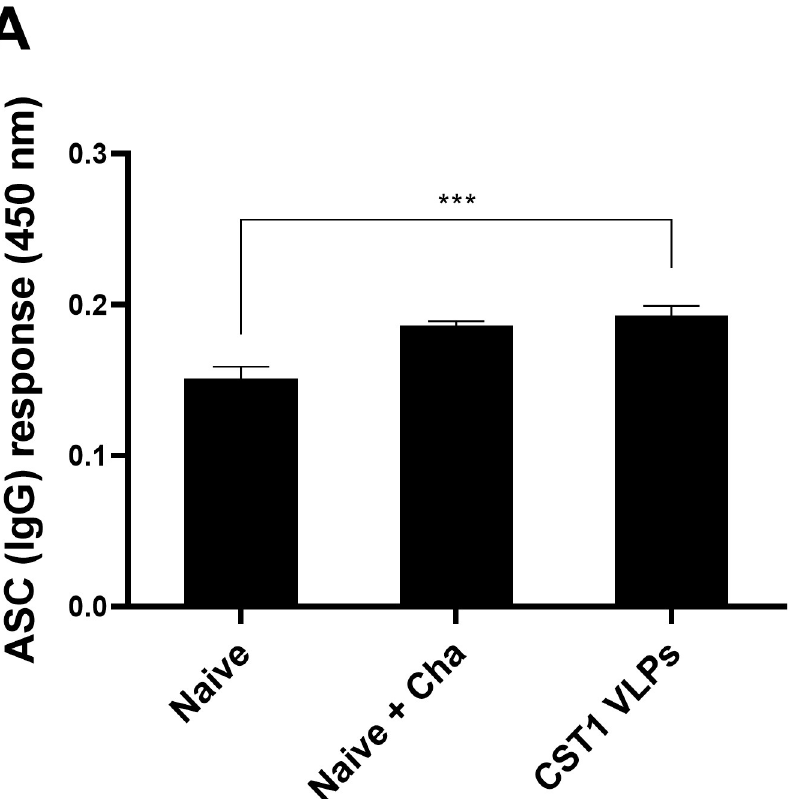
Fig 6. Splenic ASC responses. Splenocytes of individual mice were acquired at 40 dpi and seeded into 96 well plates coated with Tg ME49 Ag. T . gondii -specific IgG antibody-secreting cell response was determined by ELISA. Absorbance values at 450nm were measured and data are shown as mean ± SD, with asterisks denoting statistical significance between the groups ( *** P < 0.001). Splenocytes were collected on an individual basis and representative flow cytometry data acquired from 2 independent vaccination and challenge infection studies were